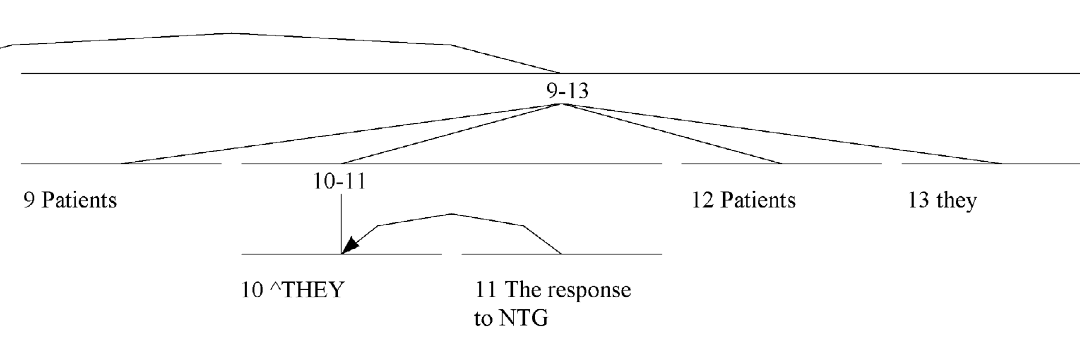
Figure 4. Theme pattern in the second subsection of